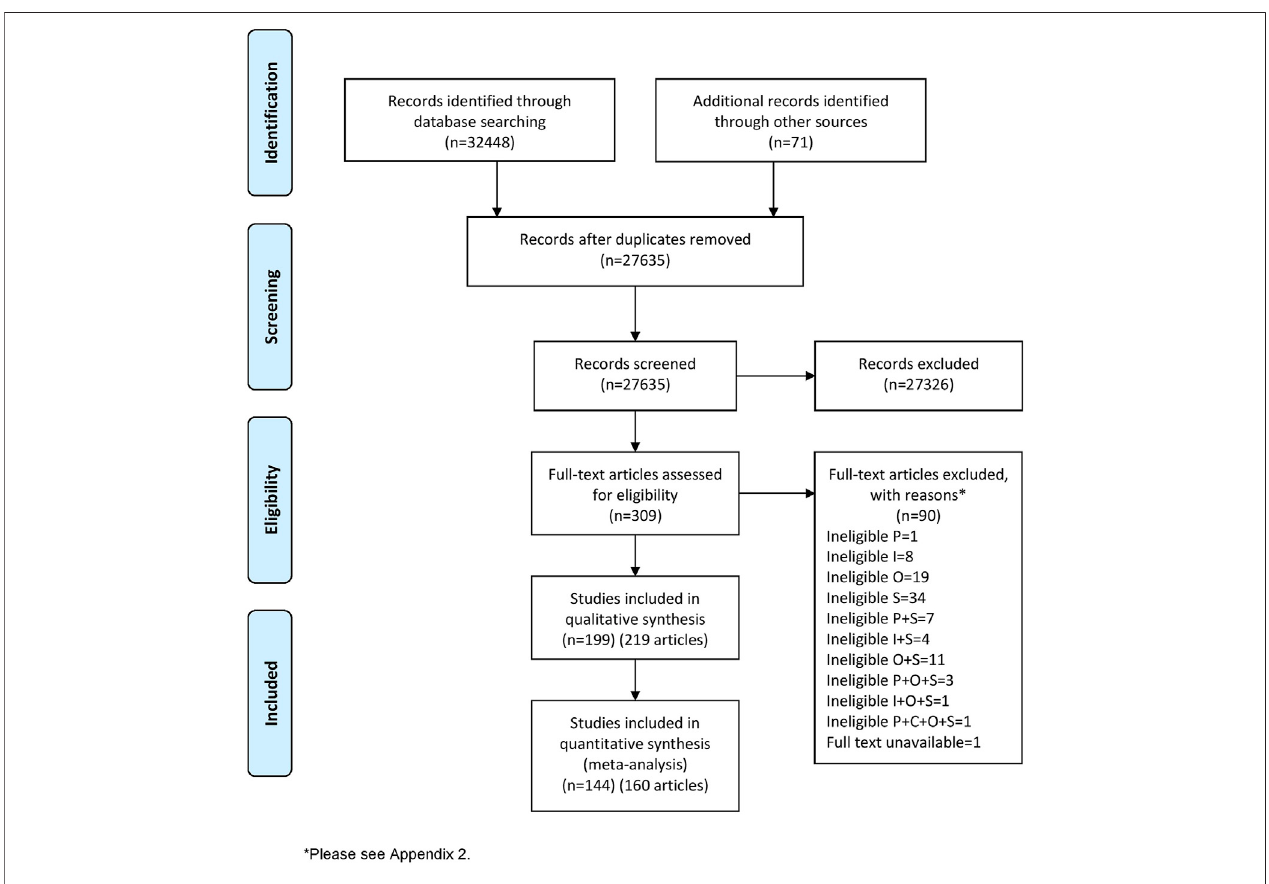
FIGURE 1 | PRISMA fl ow diagram (study selection and inclusion process).